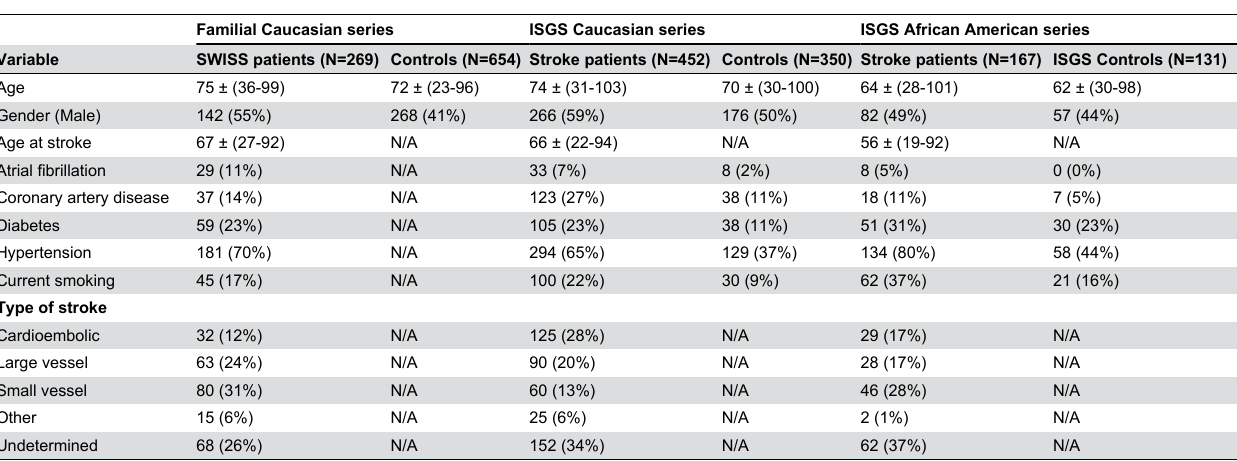
Table 1. Patient characteristics for each